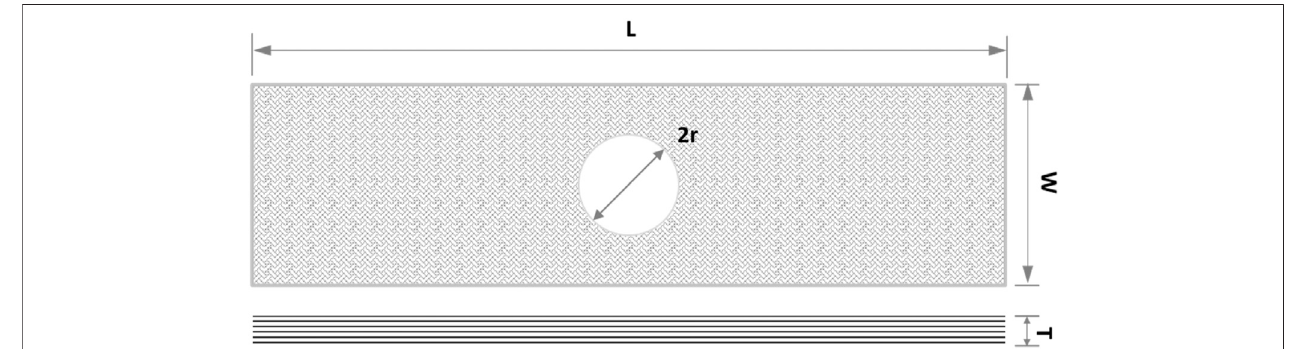
FIGURE 8 | Dimensions of the sample: L (cid:1) 150 mm, W (cid:1) 40 mm, T (cid:1) 1 mm, and r (cid:1) 2 – 10 mm.